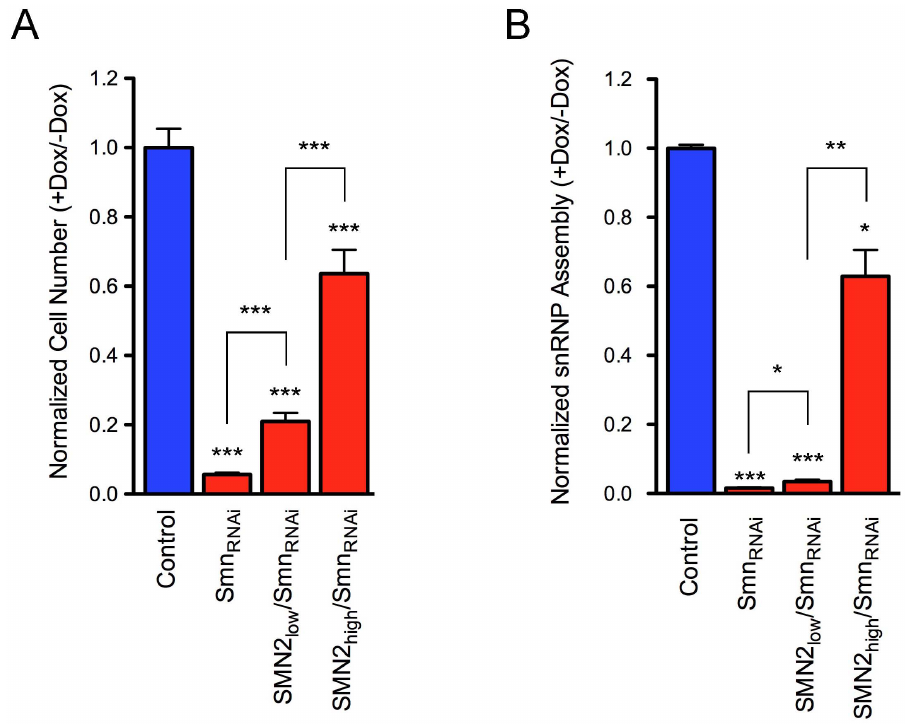
Figure 5. Effect of human SMN2 expression on proliferation and snRNP assembly in Smn-deficient NIH3T3 cell lines. (A) Analysis of cell proliferation in wild-type (Control), NIH3T3-Smn RNAi , NIH3T3-SMN2 low /Smn RNAi and NIH3T3-SMN2 high /Smn RNAi cell lines cultured with and without doxycycline for 7 days. For each cell line, the cell number ratio of Dox-treated cells versus untreated cells is expressed relative to that of wild-type cells, which is set to 1. Data are represented as mean and SEM (n $ 3; ***=p , 0.001; one-way ANOVA). (B) Analysis of U1 snRNP assembly in NIH3T3 cell lines. In vitro snRNP assembly experiments were carried out with radioactive U1 snRNA and extracts from wild-type NIH3T3 (Control), NIH3T3- Smn RNAi , NIH3T3-SMN2 low /Smn RNAi and SMN2 high /Smn RNAi cells cultured with and without doxycycline for 7 days. For each cell line, the amounts of immunoprecipitated U1 snRNA were quantified and the RNA ratio in Dox-treated cells versus untreated cells is expressed relative to that of wild-type cells, which is set to 1. Data are represented as mean and SEM (n $ 3; *=p , 0.05; **=p , 0.01; ***=p , 0.001; one-way ANOVA).